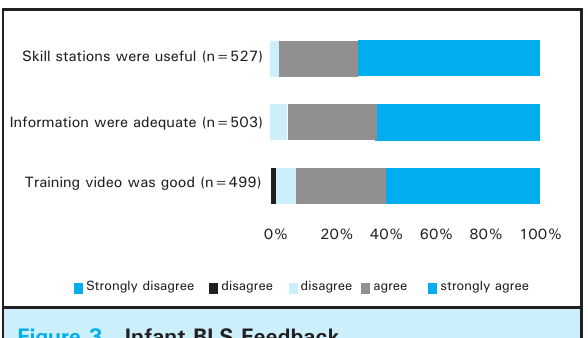
Figure 3. Infant BLS Feedback.